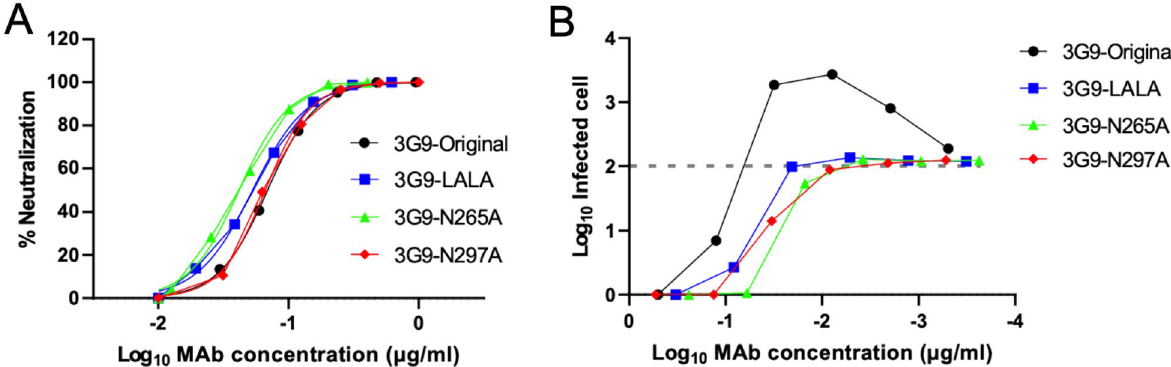
Figure 4. Neutralizing and ADE activities of the Fc-modified 3G9. ( A ) Neutralizing activity against DENV-2 NGC strain using Vero cells. Average of two independent experiments is shown. ( B ) ADE activity against DENV-2 using K562 cells. Average of two independent experiments is shown.